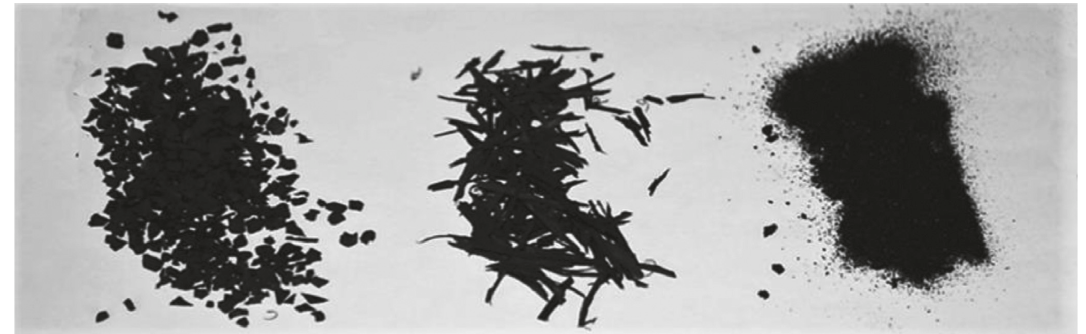
Figure 1: Granular rubber material used in the